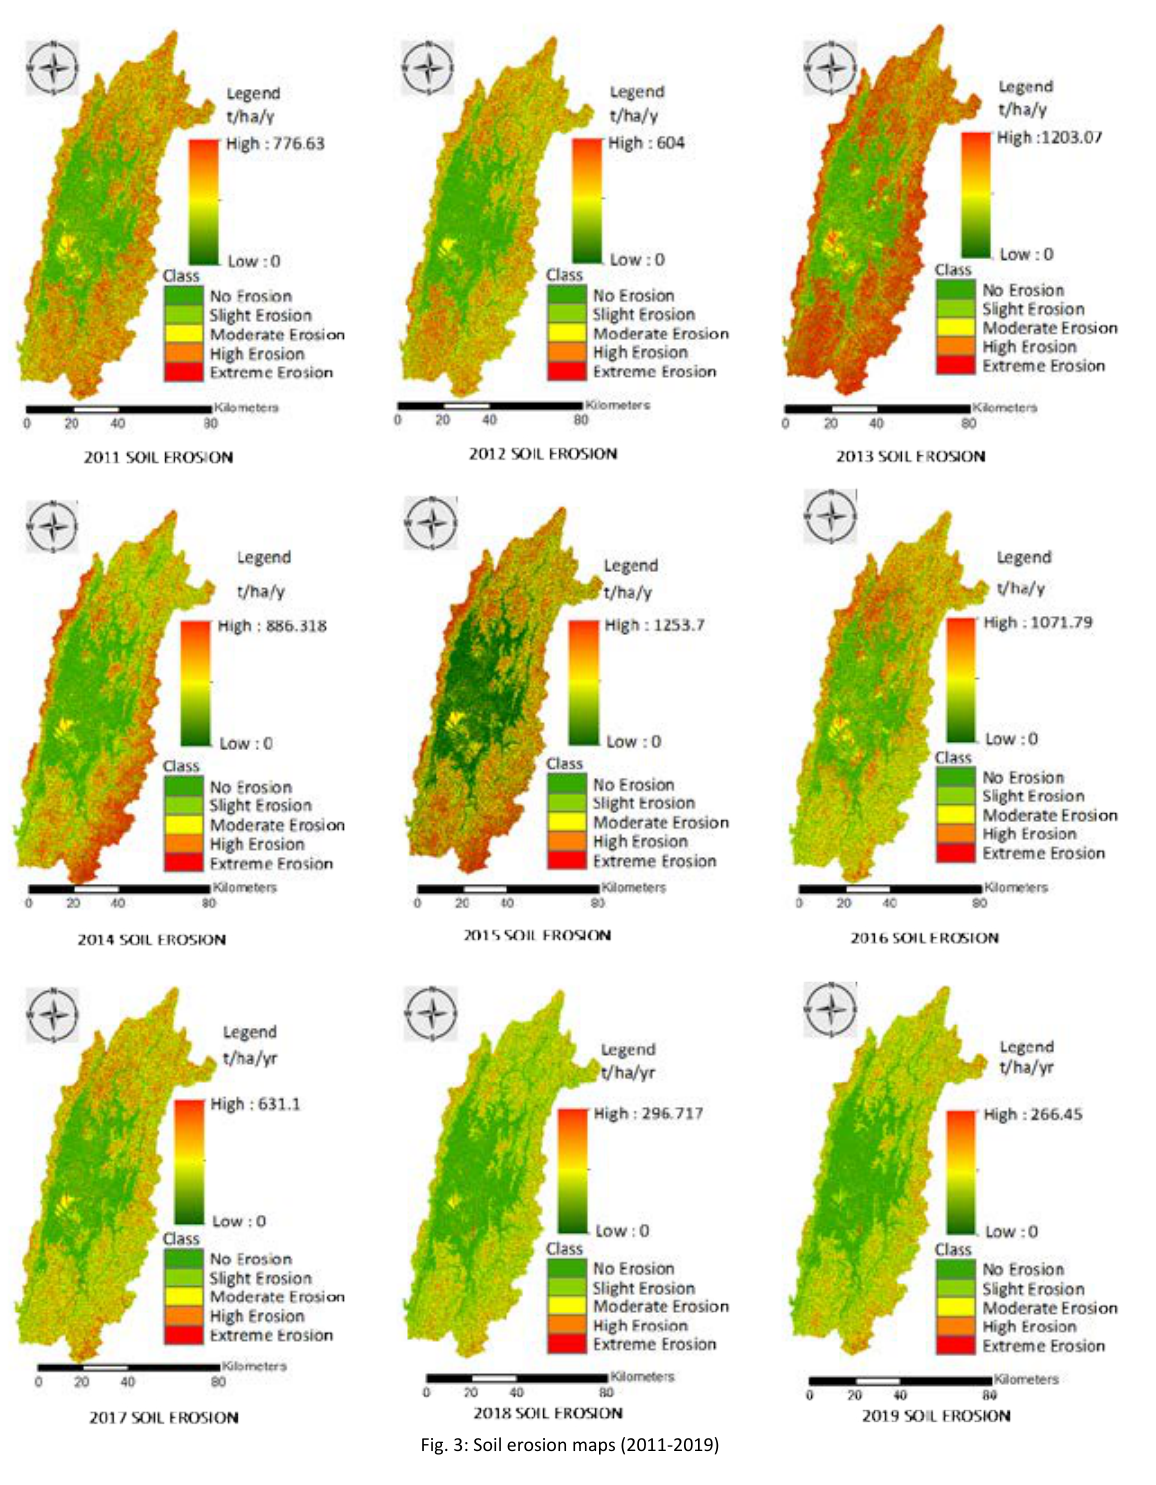
Fig. 3: Soil erosion maps (2011-2019)